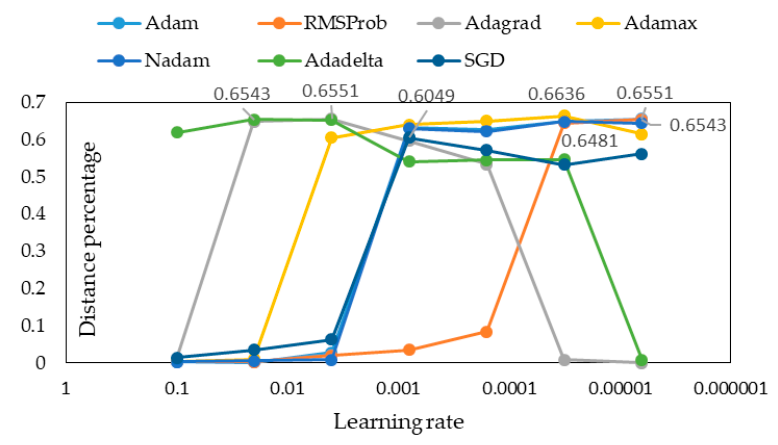
Figure 12. The distance percentage of different optimizers and learning rates.